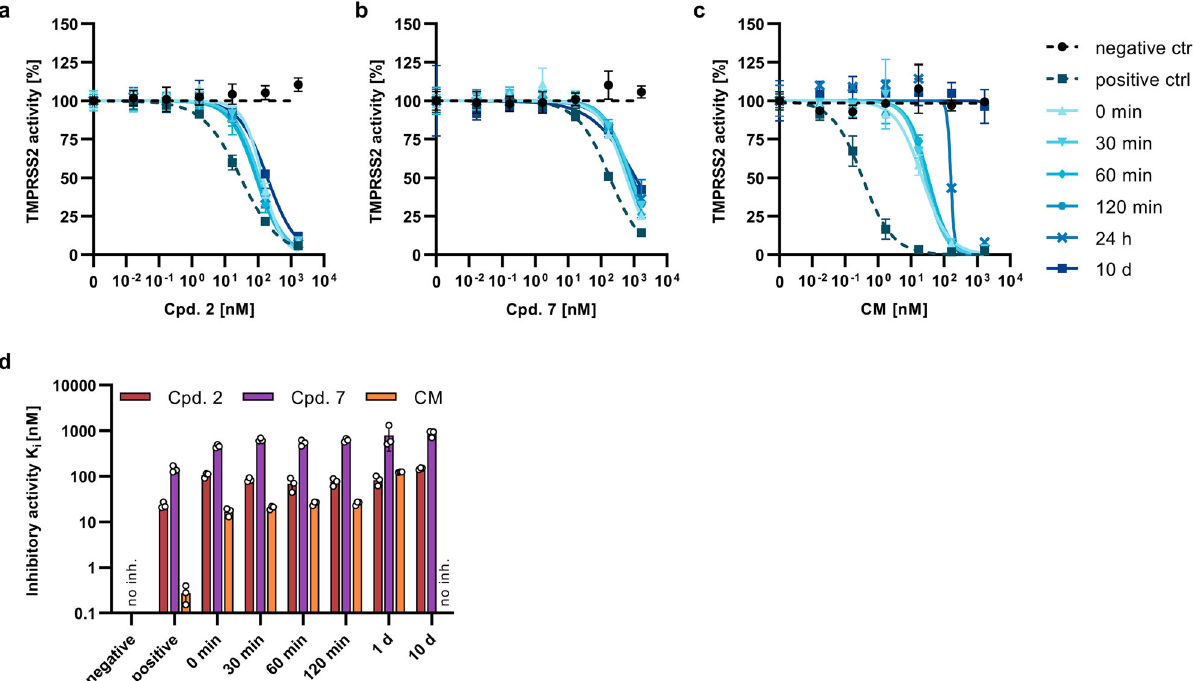
Fig. 7 Serum stability of inhibitors. Compound 2 ( a ), compound 7 ( b ), or camostat mesylate ( c ) were incubated in human serum for indicated timepoints. Samples were mixed with recombinant TMPRSS2, followed by the addition of the fl uorogenic reference substrate BOC-Gln-Ala-Arg-AMC. Graph shows normalized fl uorescence intensities after incubation for 2h. Negative ctrl: no inhibitor, positive ctrl: inhibitor in assay buffer. d Inhibitory constants K i as determined from ( a – c ). Shown are the means±SD of n = 1 experiment performed in triplicates. No inh. no inhibition. COMMUNICATIONS BIOLOGY| (2022) 5:681